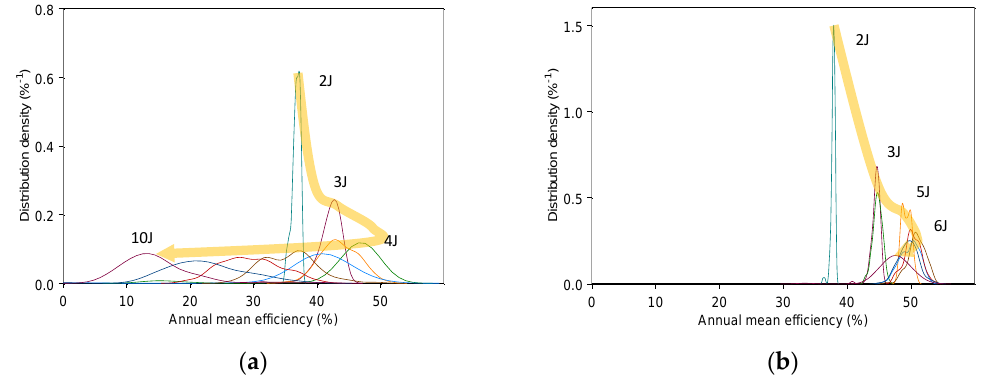
Figure 11. Optimization design result of the normal multi-junction solar cells (distribution of the annual average efficiency) under the worst-case combination of climate, atmospheric conditions, latitude, and orientation angle. The y-axis is normalized so that the integration of the distribution becomes unity: ( a ) Normal multi-junction solar cell; ( b ) Super-multi-junction solar cell.